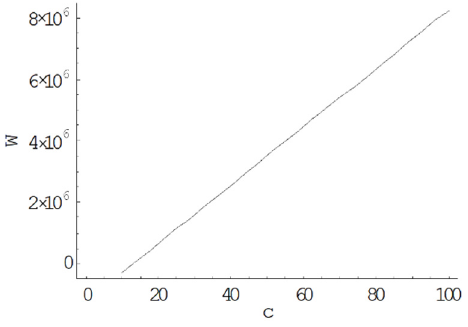
Figure 7. Total cost versus parameter c.